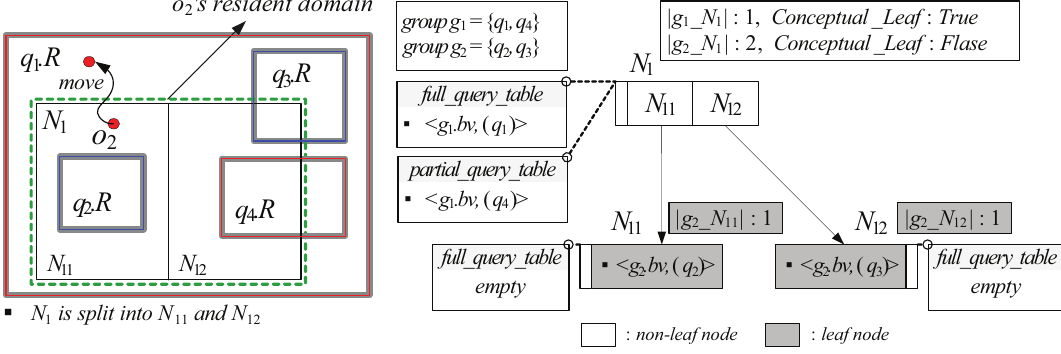
Figure 6. An example of the